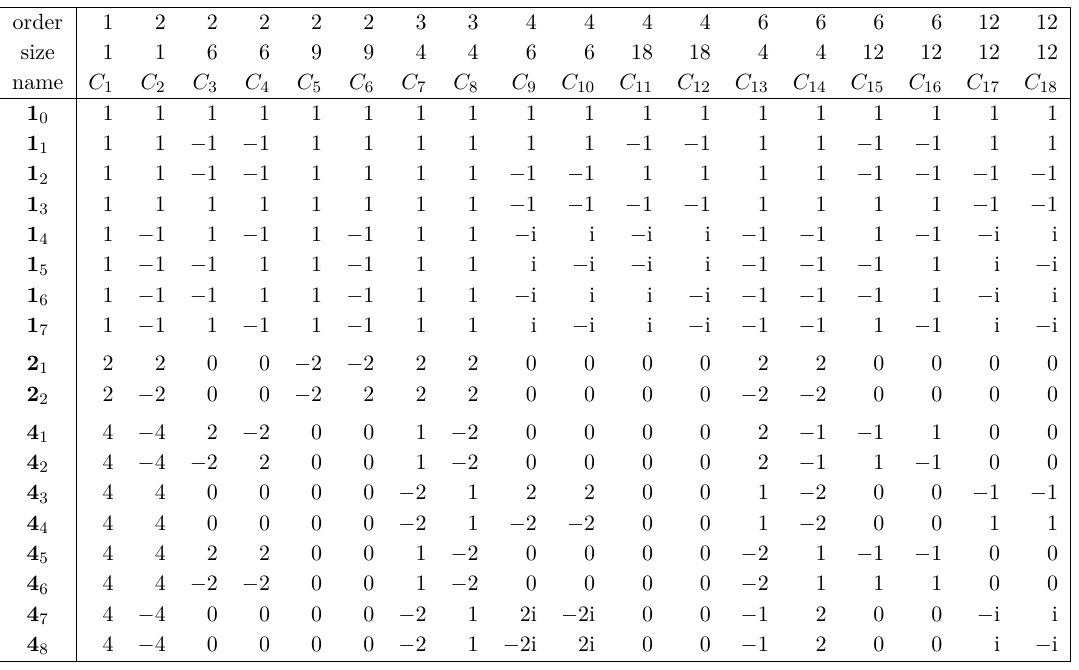
∼ = [144 , 115] , where ‘size’ means the number of ) o Z ˆ M × S U 3 3 4